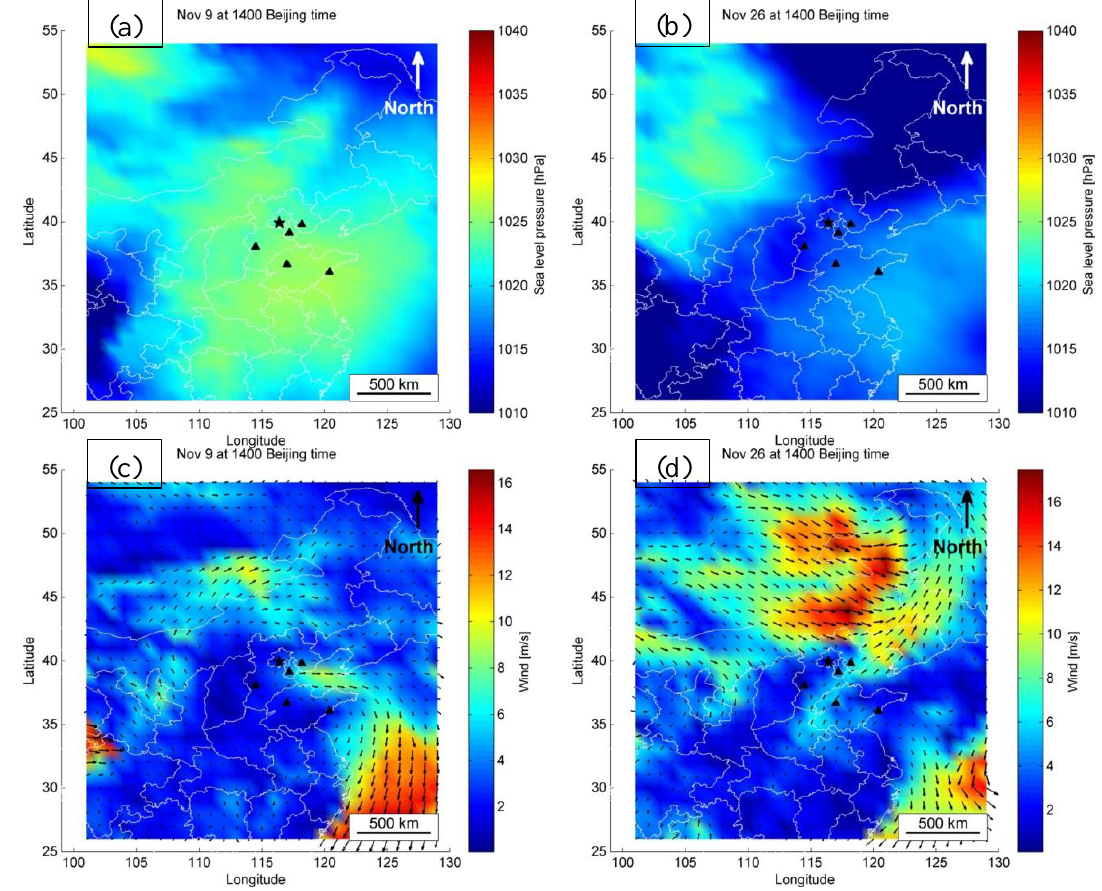
Figure 7. Sea level pressure plots (( a ) 9 November 2014 and ( b ) 26 November 2014) and surface wind plots (( c ) 9 November 2014 and ( d ) 26 November 2014) derived from NCDC observations.